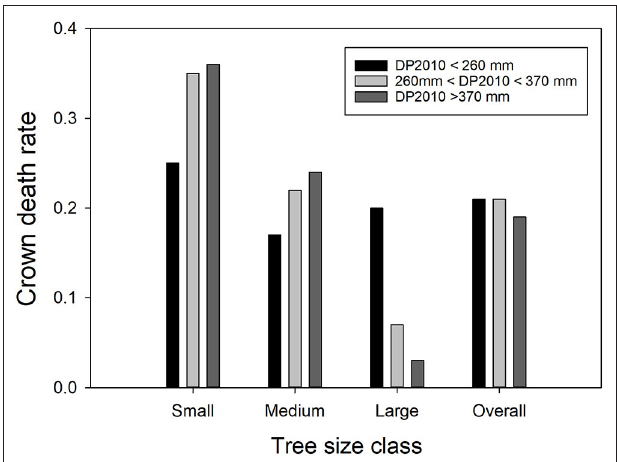
FIGURE 2 | The interactive effects of precipitation deviation from the 30-year norm in 2010 (DP2010) and Ashe juniper basal stem area on crown death rate. The bars show average crown death rates in the respective classes. Precipitation data were binned into three classes with approximately equal membership. Small trees had basal stem areas of 8 to 38 cm 2 , medium trees of 39.1 to 169 cm 2 and large trees of 170 to 7170 cm 2